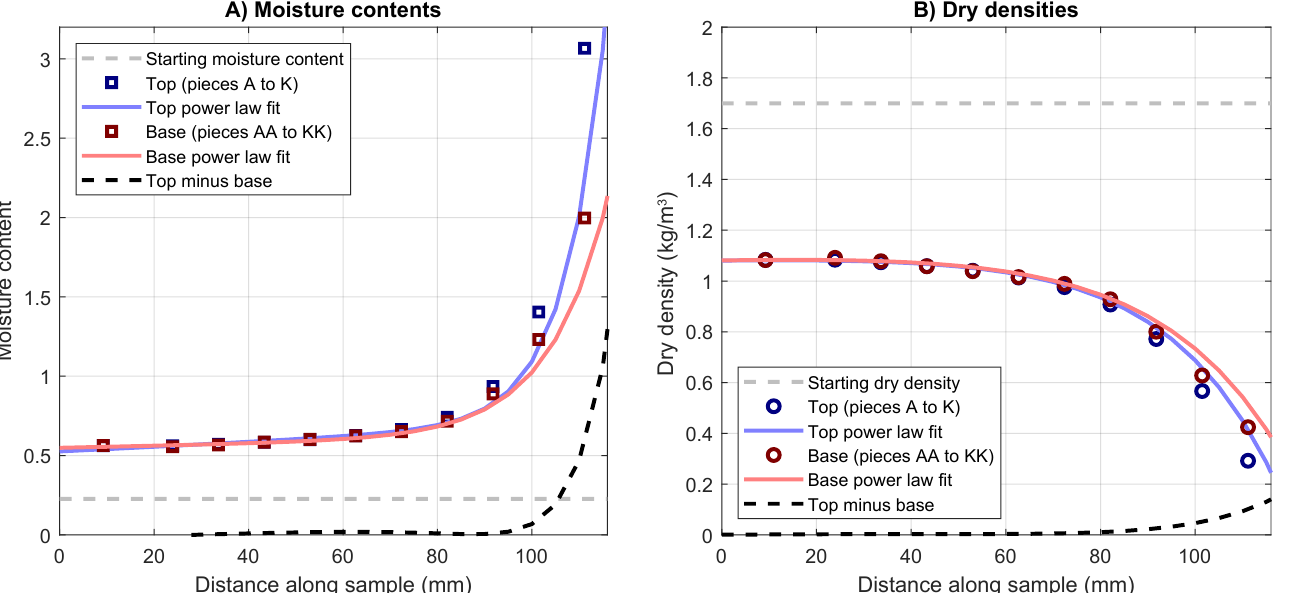
Figure 2. ( A ) Moisture contents and ( B ) dry densities along the length of the post-test sample. The moisture content has increased and the dry density has decreased at all points along the length of the sample from the starting